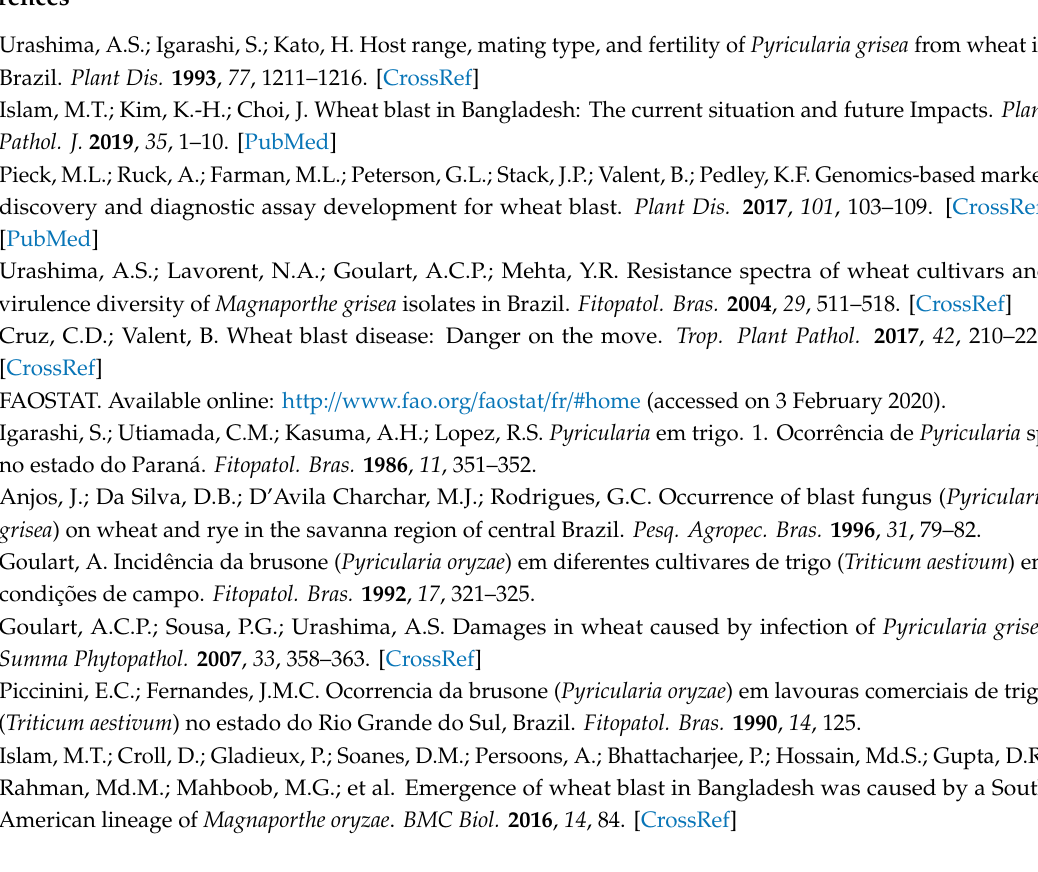
Figure S1: PCR primer screening using a small panel. Green: specific amplification; red: non-specific amplification; white: no amplification; Figure S2: LAMP primer screening using a small panel. Green: specific amplification; red: non-specific amplification (min); Table S1: List of DNA used in this study; Table S2: List of candidate primers and probes used in this